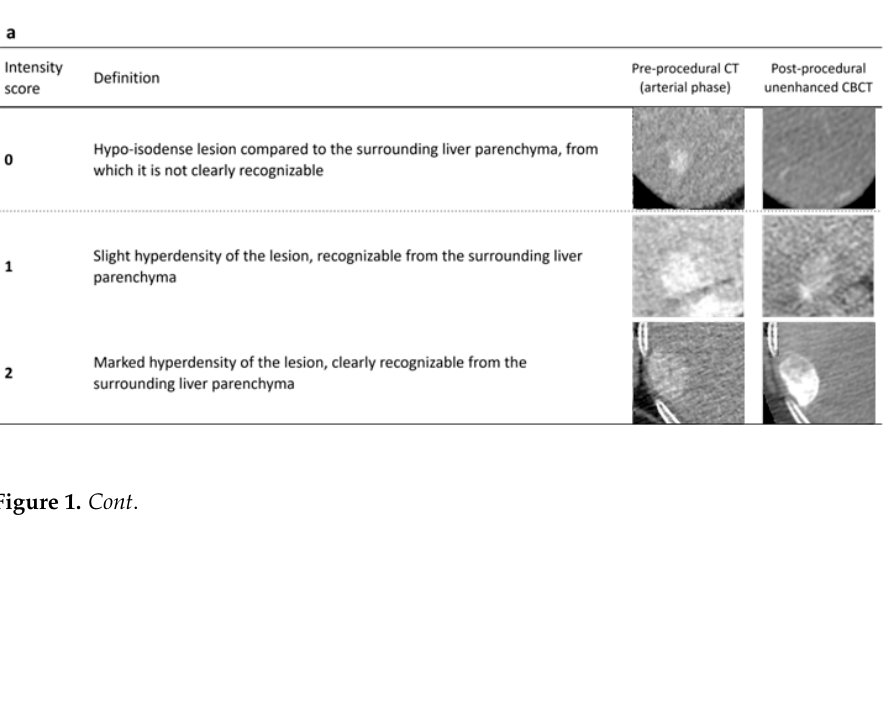
Figure 1. Subjective score visually assigned by the two radiologists for intensity ( a ), homogeneity ( b ), and margins ( c ) of contrast media deposit in unenhanced post-interventional CBCT. 2.5. Preoperative and Follow-Up Imaging All patients underwent four-phase contrast-enhanced CT (CECT) within 2 months before the procedure and between 30 and 60 days after the procedure, according to the American Association for the Study of Liver Diseases (AASLD) guidelines [18]. In the preoperative CECT, the maximum diameter (Dmax) of the lesions was measured. The study was carried out in a tertiary referral center; preoperative imaging was performed partly by our diagnostic radiology service and partly by other centers. All cases were discussed by the multidisciplinary board of the referral institution, which included at least two radiologists and one interventional radiologist. As regards the follow-up imaging, responses were assessed on hepatic-arterial CT images using the modified Response Evaluation Criteria In Solid Tumors (mRECIST) system [12], classifying them as complete response (CR), partial response (PR), stable disease (SD), or progressive disease (PD). The FU was evaluated by two independent